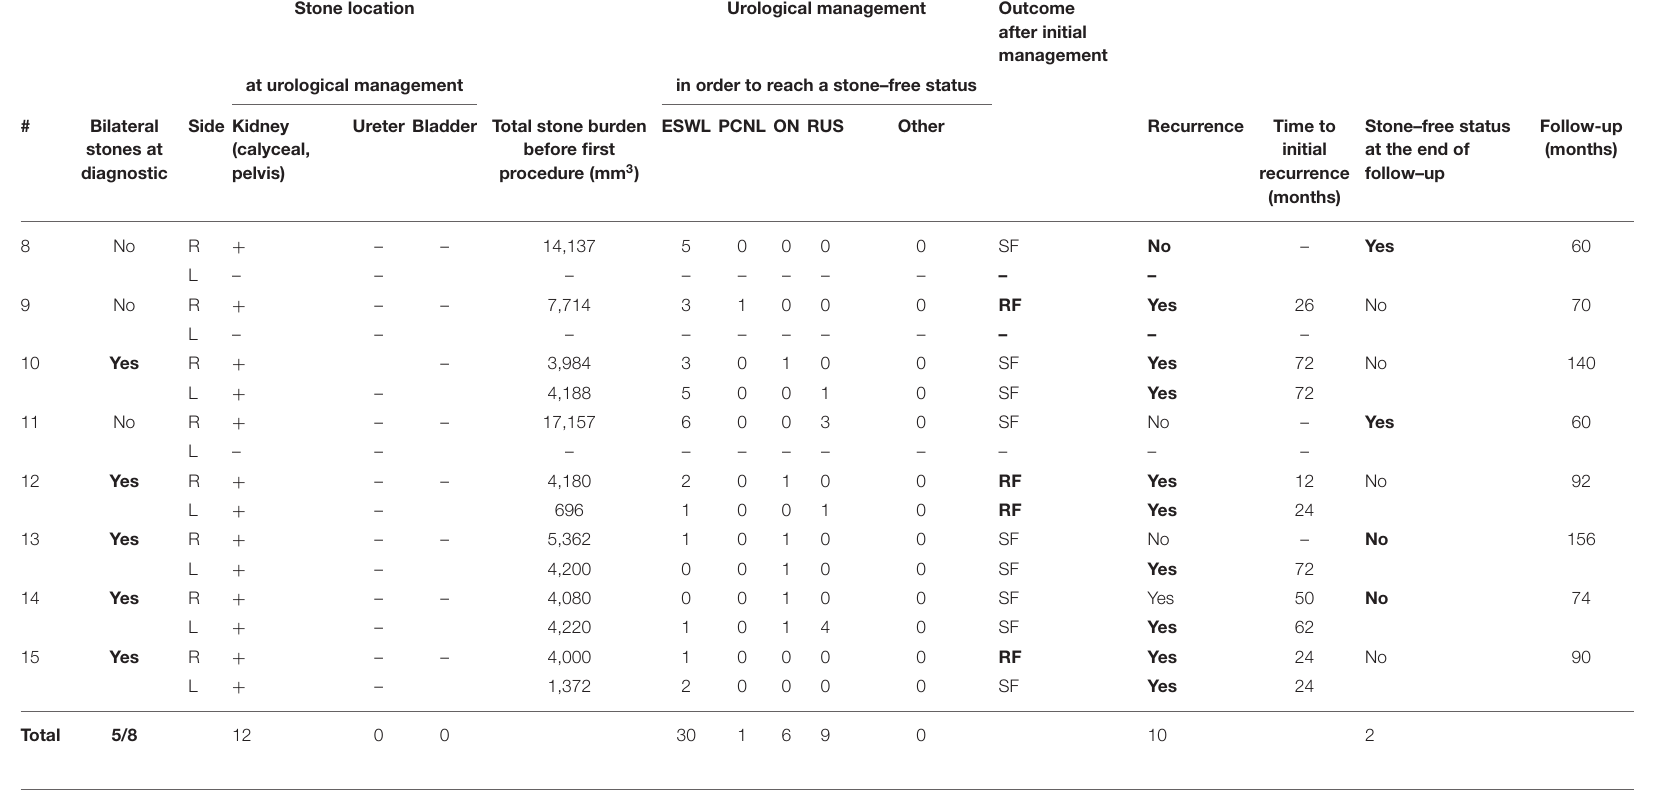
TABLE 3 | Results in group 2 (children older than 2 years